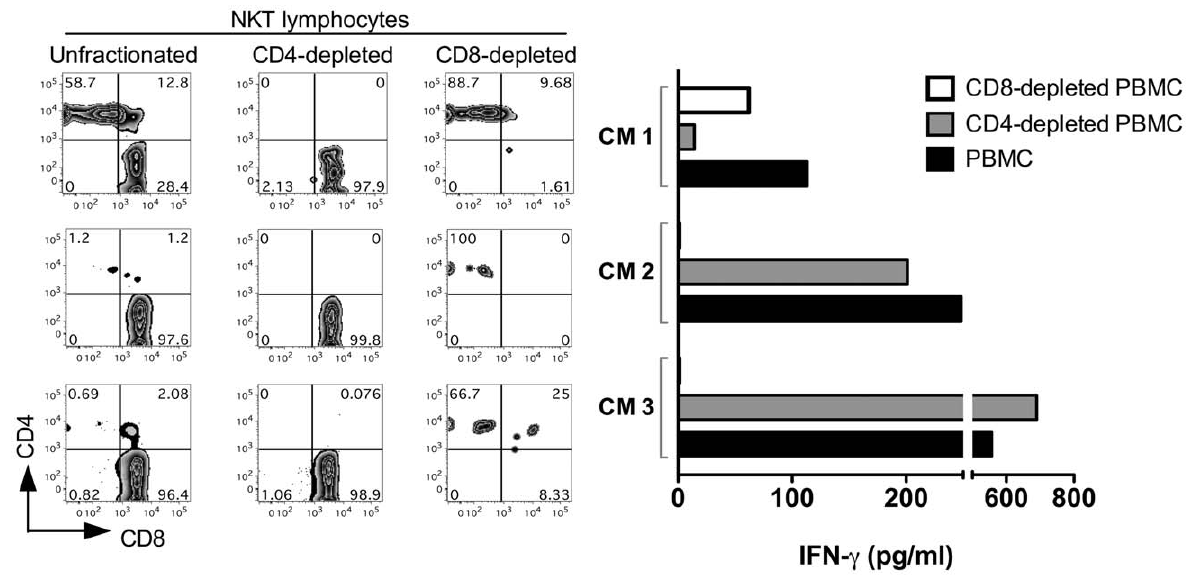
Figure 7. IFN- c production by cynomolgus macaque NKT lymphocyte subsets. Contour plots showing CD4 and CD8 expression on NKT lymphocytes from 3 SIV-negative CM (CM1, CM2 and CM3). Bar histograms on the right show IFN- c production by respective cynomolgus macaque PBMC either depleted of CD8 + subsets (empty bars) or CD4 + subsets (grey bars), in response to 24 h CD1d/ a GC stimulation. IFN- c amounts secreted by NKT lymphocytes in PBMC not depleted of either CD8 + or CD4 + cells are denoted as black bars. Depletion of CD8 + T cells from CM2 and CM3 prior to stimulation with CD1d/ a GC resulted in abrogation of IFN- c production by NKT lymphocytes. doi:10.1371/journal.ppat.1002928.g007 PLOS Pathogens |